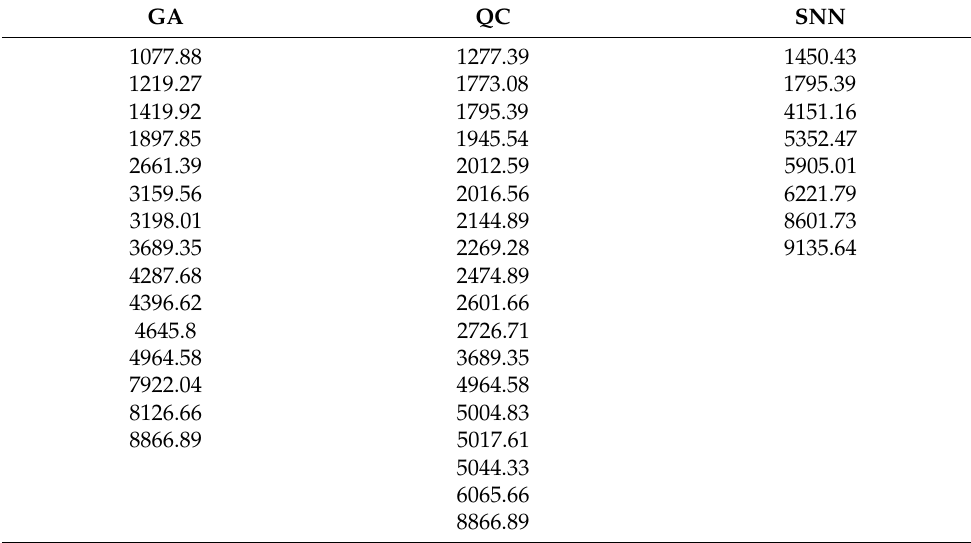
Figure 4. Average MALDI-TOF MS spectra of serum samples characteristic of study groups. Spectra of patients allergic to plant storage proteins (red) and controls (green) are presented over the full scan range of m / z 1000–10,000. Table 2. Peaks ( m / z ) discriminating study groups calculated by genetic algorithm (GA), supervised neural network (SNN) and quick classifier